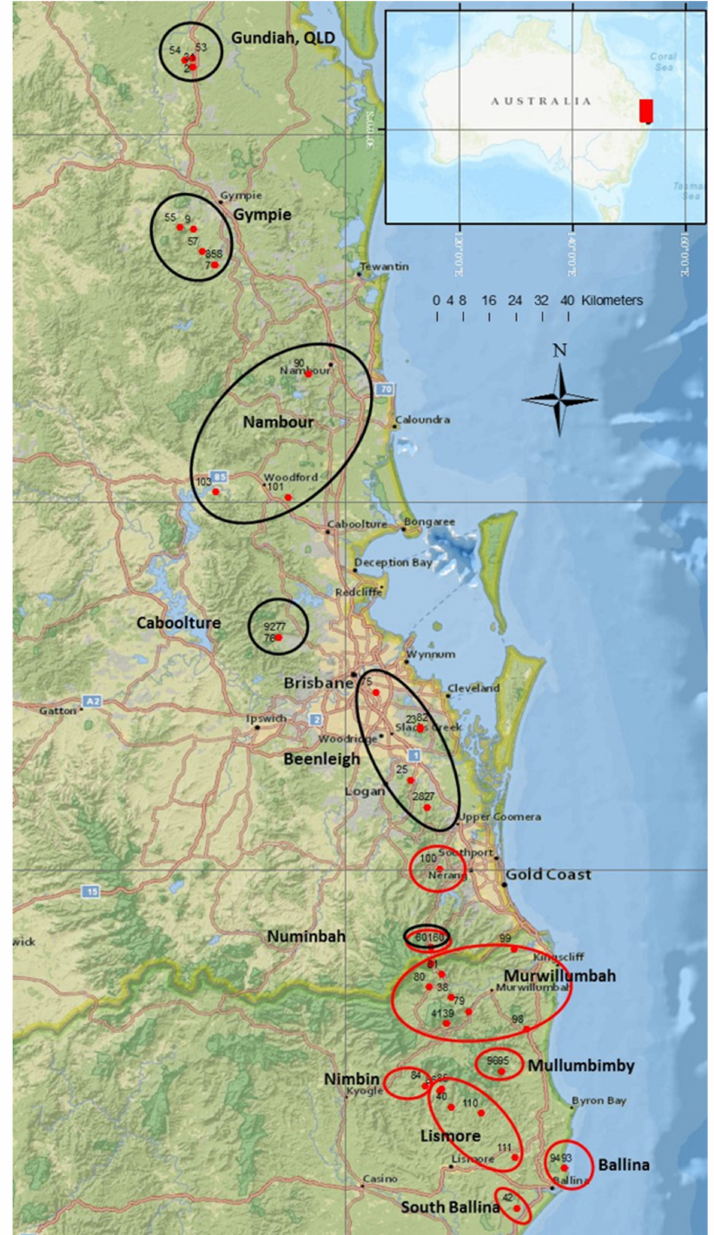
Figure 6. Map showing origins of representative wild-germplasm accessions of M. integrifolia and M. tetraphylla . The black circles represent six localities of M. integrifolia population, and the red circles represent eight localities of M. tetraphylla